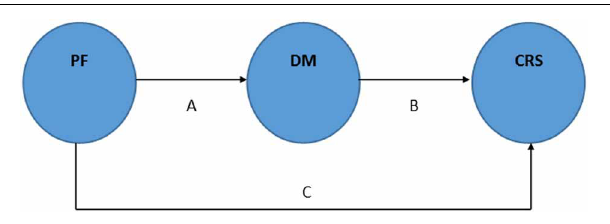
FIGURE 4 | Schematic representation of the mediator hypothesis: mindfulness as mediator (A + B) of the physical fitness effects on cardiovascular responses to stress. Adapted from Baron and Kenny (1986). PF: physical fitness. DM: dispositional mindfulness. CRS: cardiovascular responses to